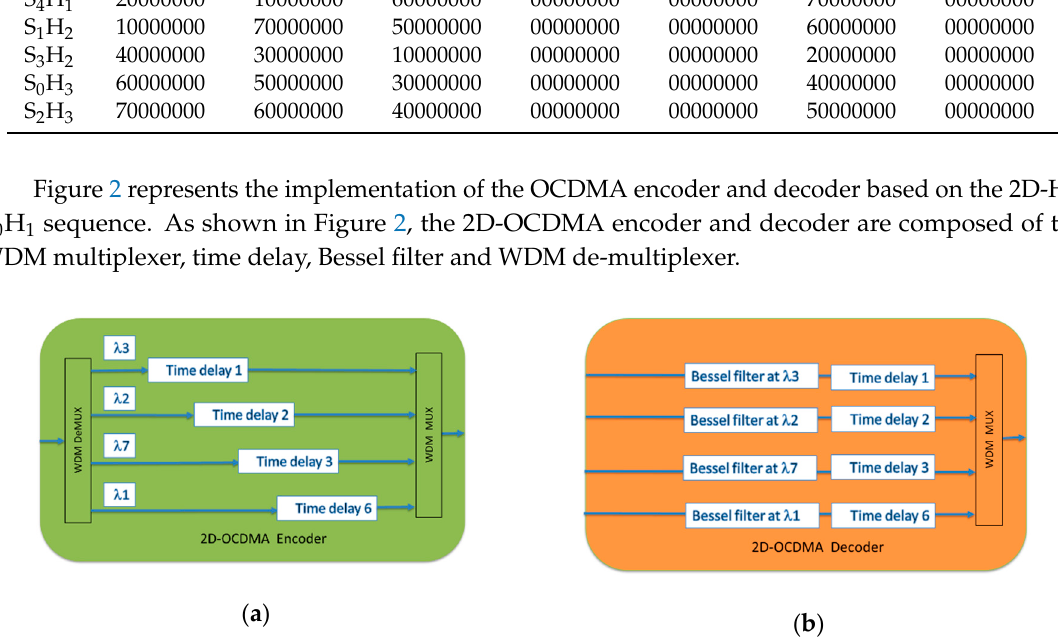
Figure 2. Implementation of 2D-HC for S 0 H 1 sequence. 2D-OCDMA encoder based on S 0 H 1 sequence ( a ); 2D-OCDMA decoder based on S 0 H 1 sequence ( b ).